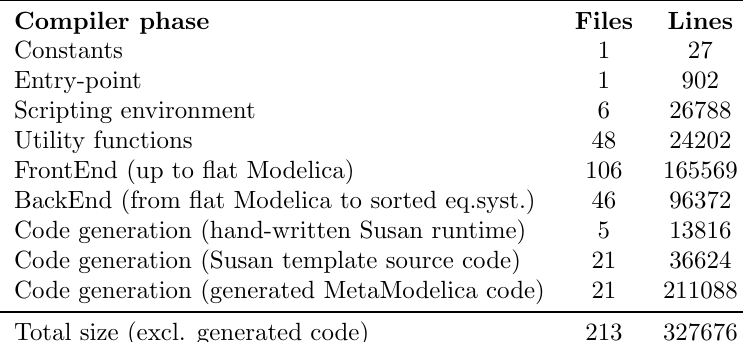
Table 1: Sizes of OMC Compiler Phases, Lines of